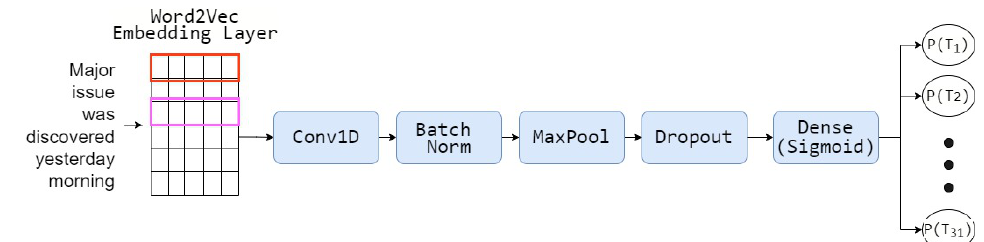
Figure 4. Architecture of the CNN with Word2Vec